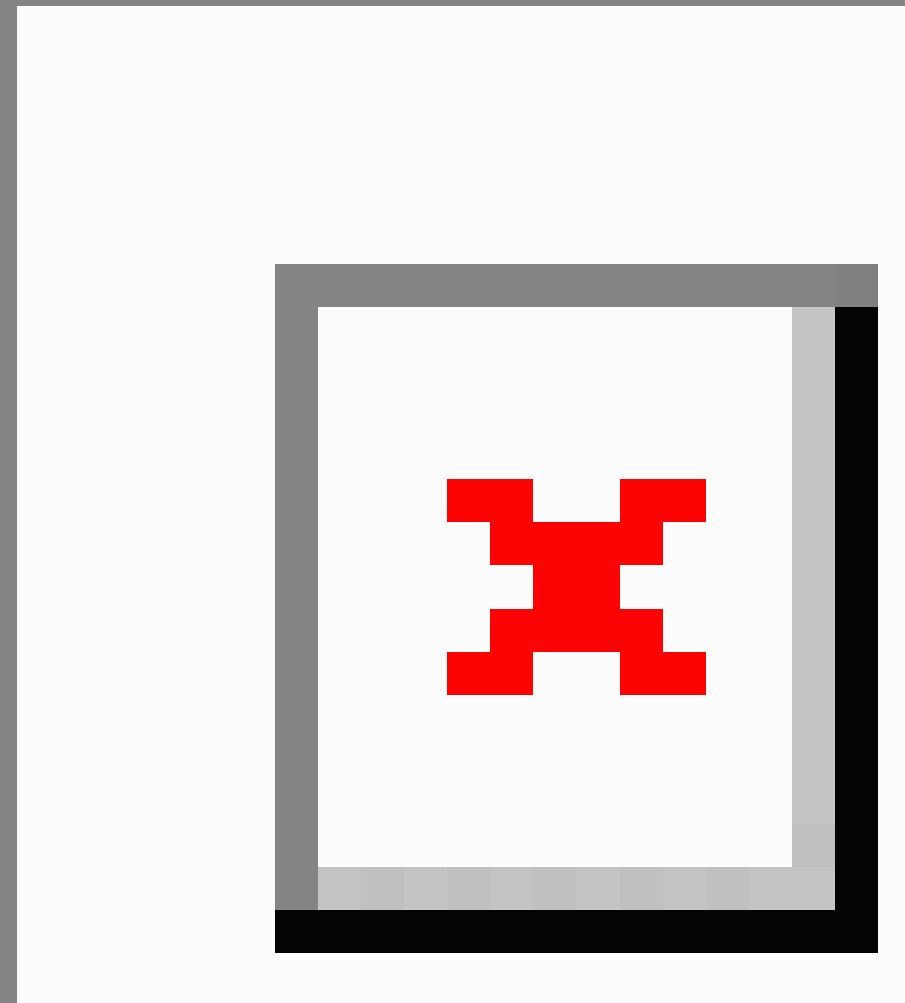
Figure 3. Example of part of the feedback delivered in